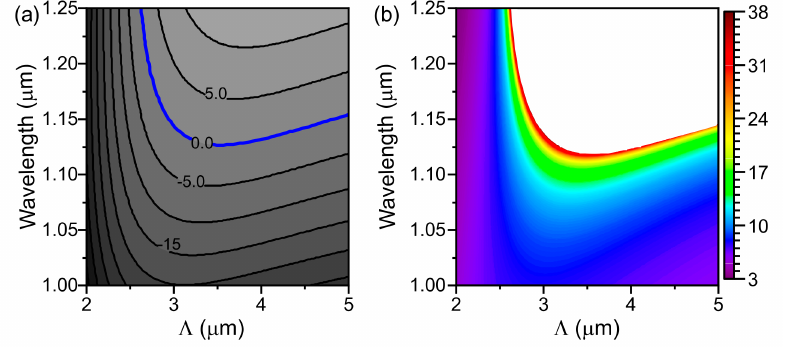
Figure 4. ( a ) Chromatic dispersion as a function of optical wavelength and fiber pitch for D 2 O-filled PCFs. Numbers indicates dispersion levels in ps/km · nm. ( b ) Frequency shift map of PMI–SF; color bars are detuning frequencies values in THz. Parameters used in the simulations: d/ Λ = 0.56, P = 3